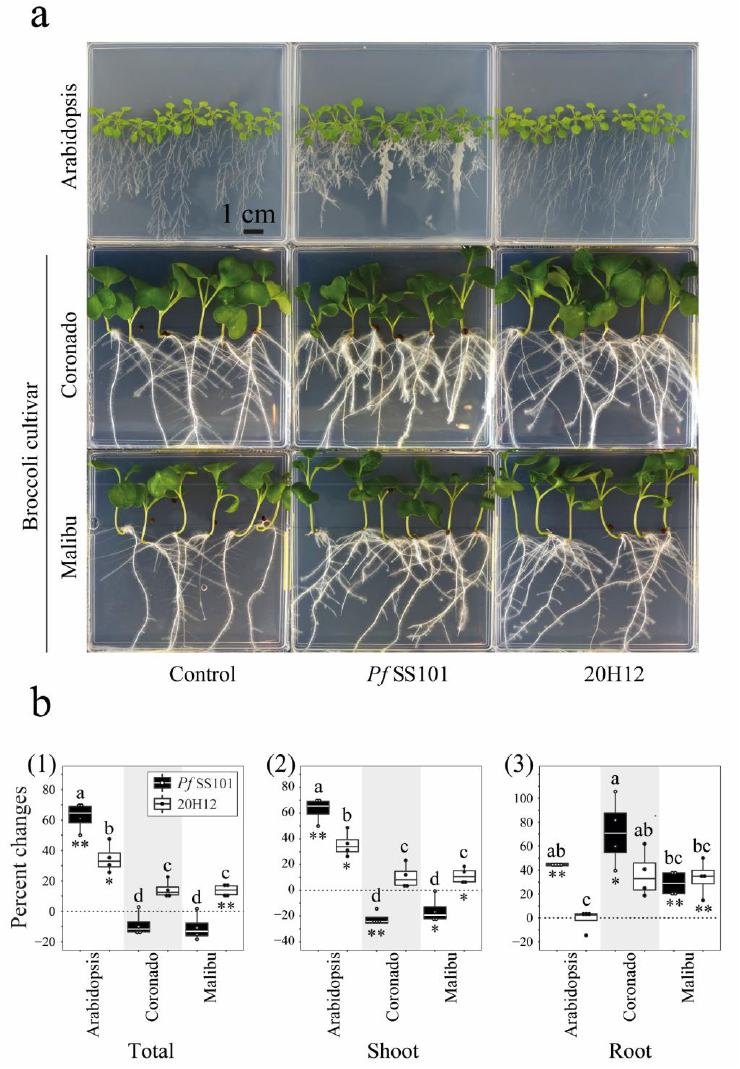
Figure 1. Phenotypic changes in Arabidopsis and Broccoli seedlings upon root treatment by P. fluo- rescens SS101 or its cysH mutant 20H12. Photographs of MS agar plates with Arabidopsis , and two Broccoli cultivars (Coronado and Malibu) treated on the root tip with cell suspensions of Pf SS101 (wild type) or its cysH mutant (20H12) ( a ). Percentage change in total fresh biomass ( 1 ), shoot ( 2 ), and root ( 3 ) of plants treated with rhizobacteria when compared to untreated plants (11dpi) ( b ). Means of percent changes in biomass with a different letter are significantly different among treat- ments according to two-way ANOVA (Tukey, p < 0.05). Asterisks denote statistically significant differences (two- tailed Student’s t test): * p < 0.05; ** p < 0.01 of rhizobacteria treated plants when compared to the controls. For each plant species, four independent biological replicates were used with 10 seedlings of Arabidopsis and five of Broccoli per biological replicate. Pf SS101: Pseudomonas fluorescens SS101, 20H12: cysH mutant of Pf SS101.